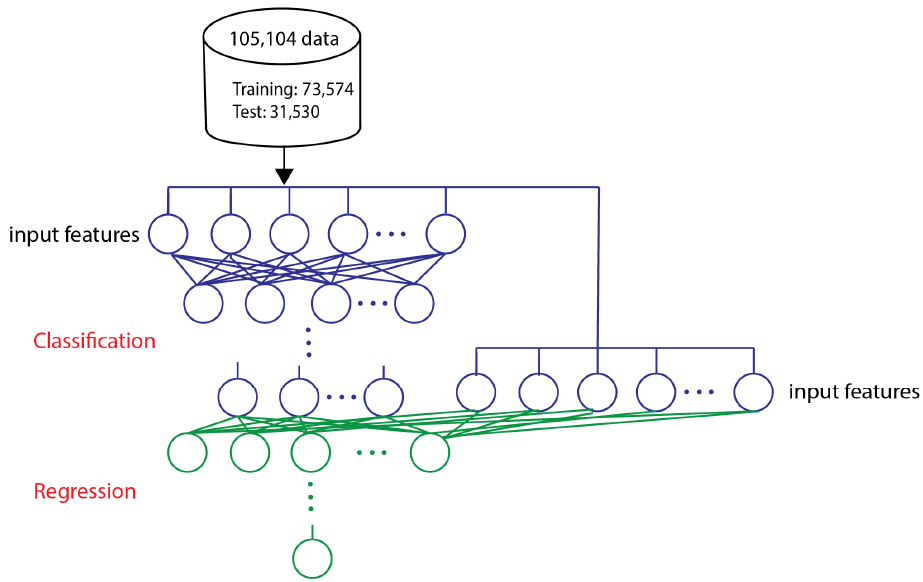
Figure 3. Hybrid model (combining the best architecture of the classification and regression mod-